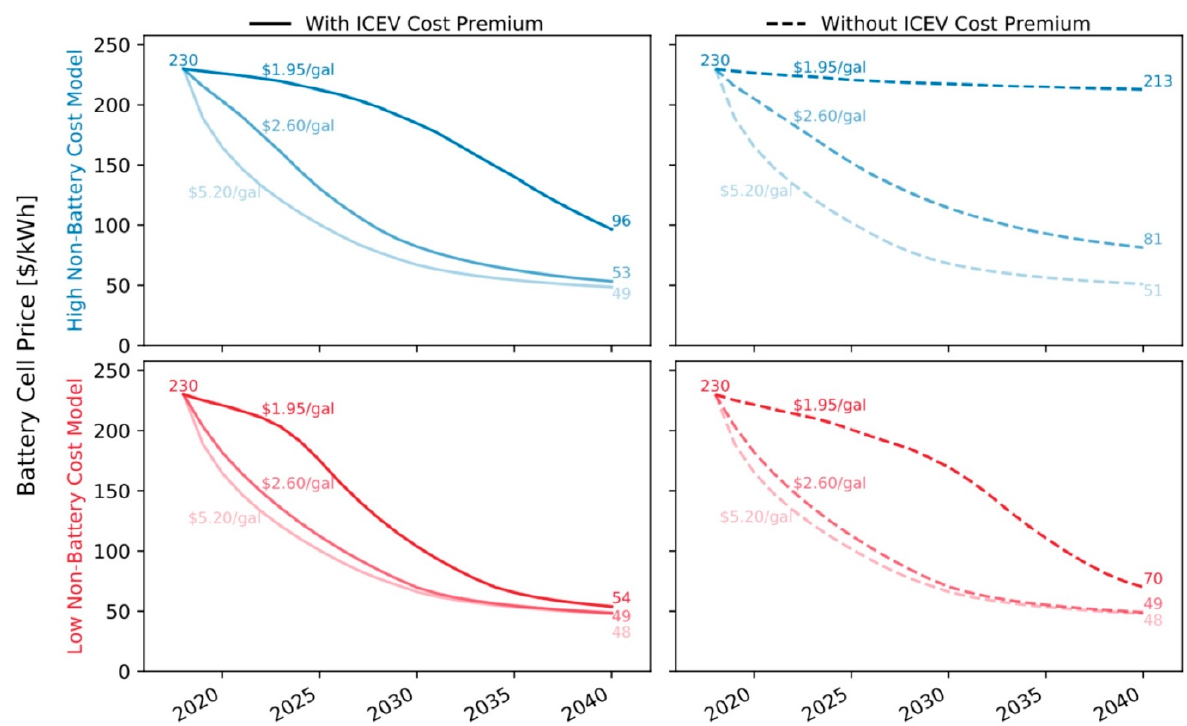
Figure 5. Reduction in battery cell price (USD/kWh) over time for scenarios with different gasoline prices, non-battery cost, and ICEV Cost Premiums, with heterogeneous consumers. For the Low Non-Battery Cost Model, ETVs are adopted, and battery prices fall quickly regardless of gasoline price and ICEV Cost Premium. For the High Non-Battery Cost scenarios, low gasoline prices lead to high battery costs and low market share in 2040 (1 USD/gallon = 0.25 EUR/L).